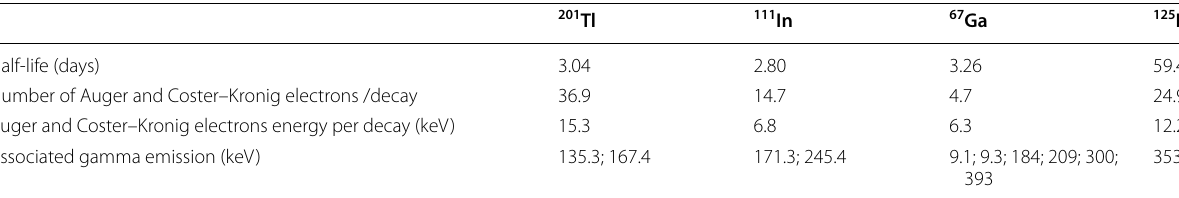
Table 1 Characteristics of some of the Auger electron emitters